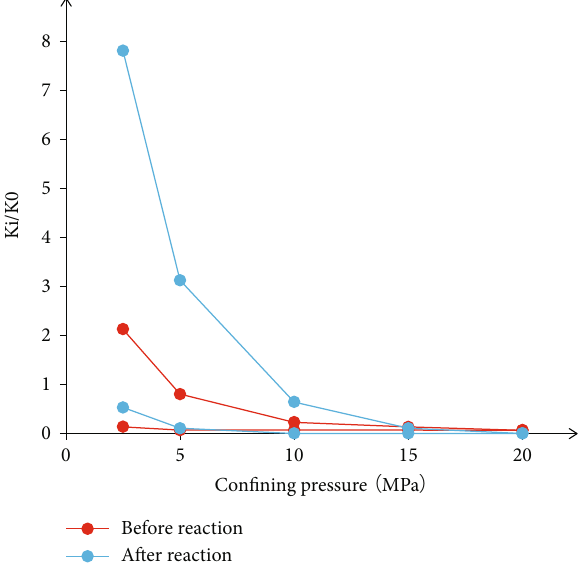
Figure 4: Stress sensitivity of shale before and after interactions with distilled water for 48 h.